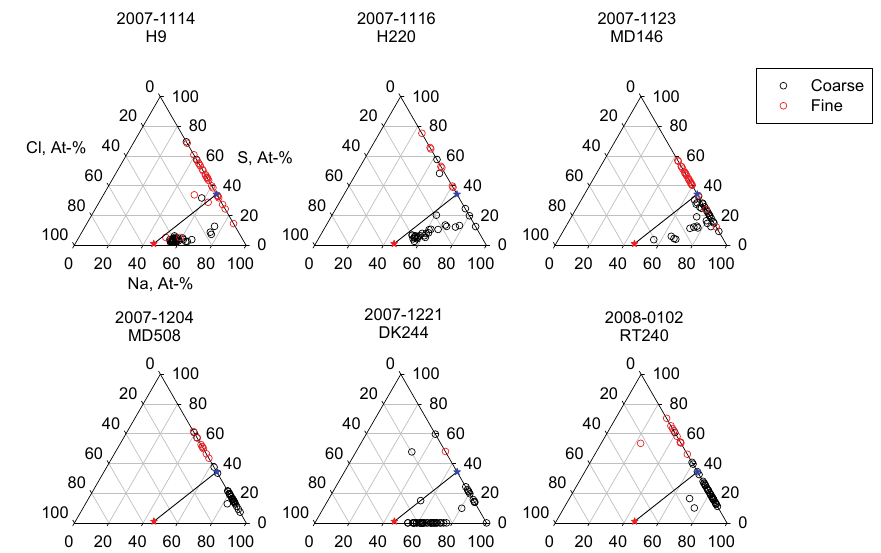
Fig. 10 Figure 10. Ternary plots (Na-S-Cl) of sea-salt particles in coarse and fine modes during the JASE traverse. Red, and blue stars respectively